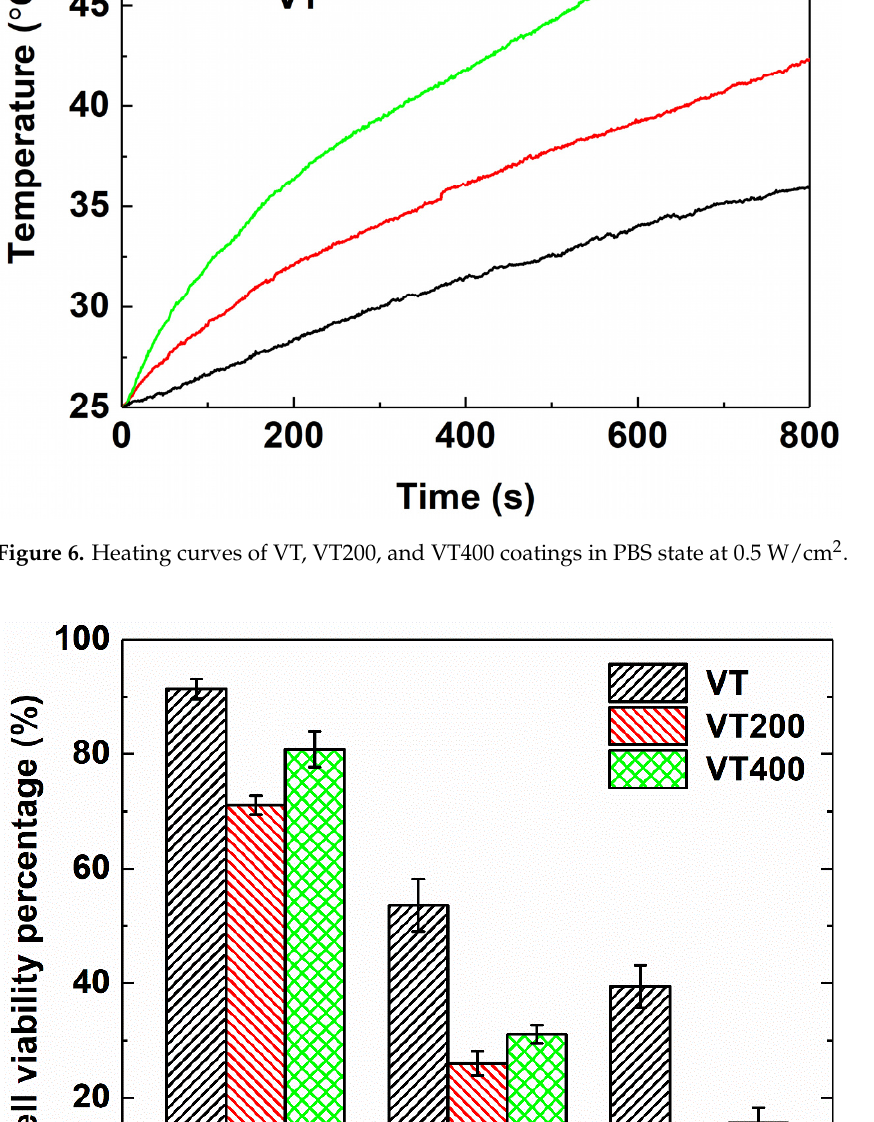
Figure 8. Confocal images of cells on VT, VT200, and VT400 before ( a – c respectively) and after ( d – f respectively) irradia- tion. 4. Conclusions In summary, we prepared tantalum coatings using a plasma spraying method and thermal treatment. The Ta coating showed partial oxidation after 1 h of heat treatment at low temperatures (200 °C and 400 °C), and the formation of oxygen vacancies narrows the